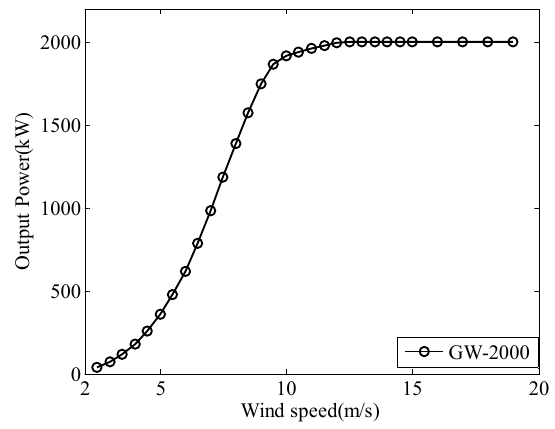
16 of 22 Figure 13. Scattered plot of wind speed of target site versus reference site with best fit line from